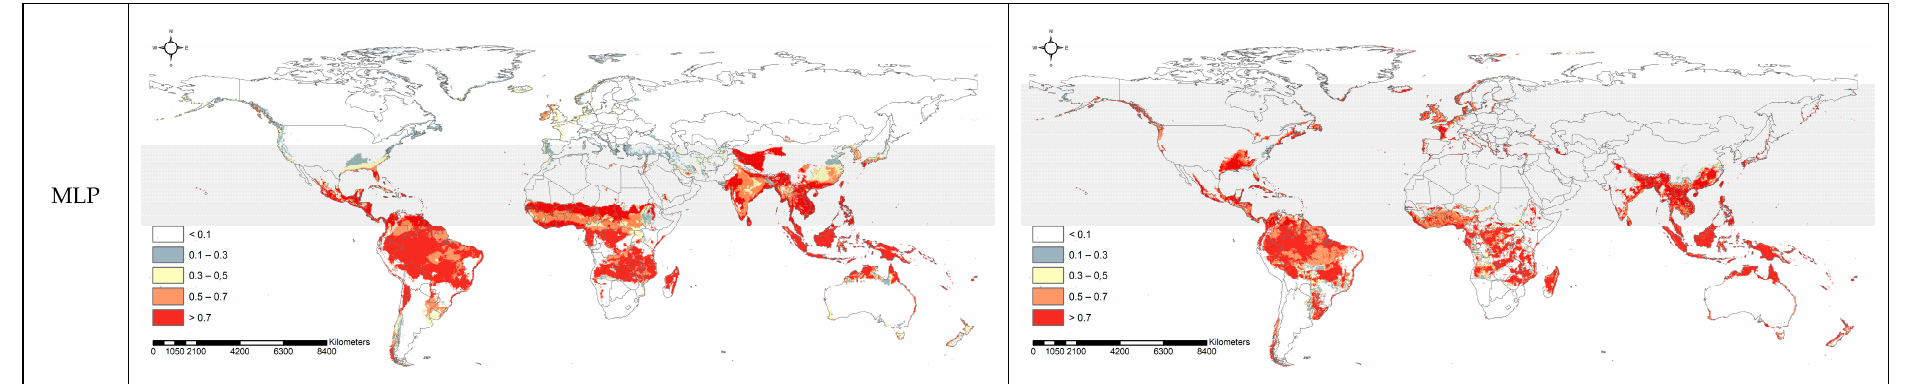
Figure 5. Potential distribution of A. gracilipes by regressing occurrence possibility evaluated by each model and climate change scenario.